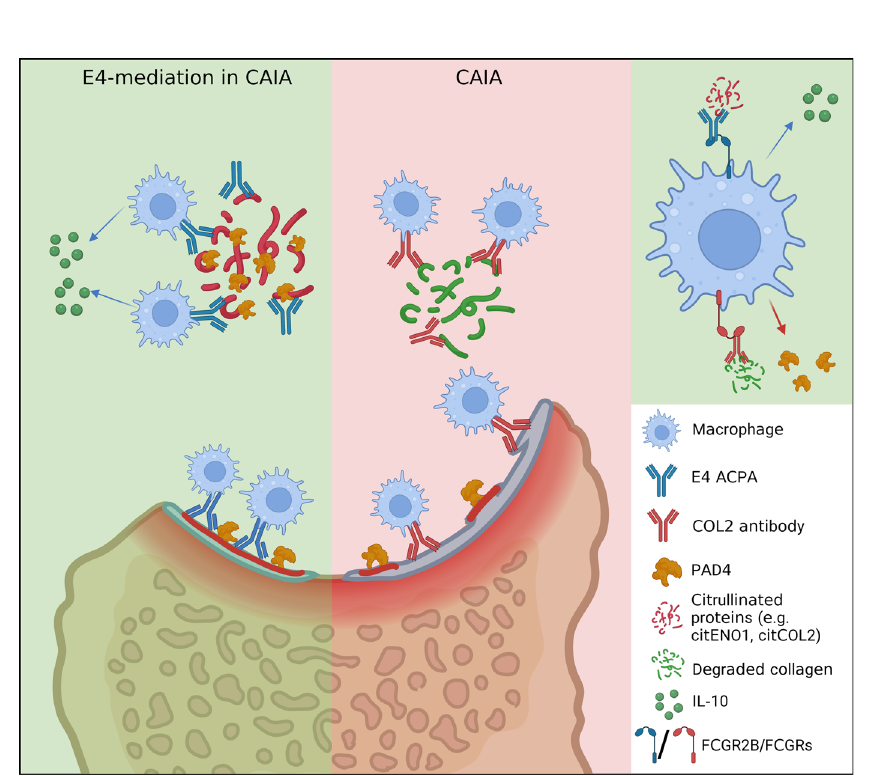
Fig. 7 | Schematic proposal for thefunction ofE4 ACPAin effector arthritis. In collagen antibody-induced arthritis (CAIA), macrophages are activated by LPS- mediated TLR signaling and arthritogenic immune complexes, leading to an increasedsecretionofPAD4.PAD4-mediatedcitrullinationgeneratesantigensthat could be recognized by ACPAs. E4 binds to certain group of citrullinated